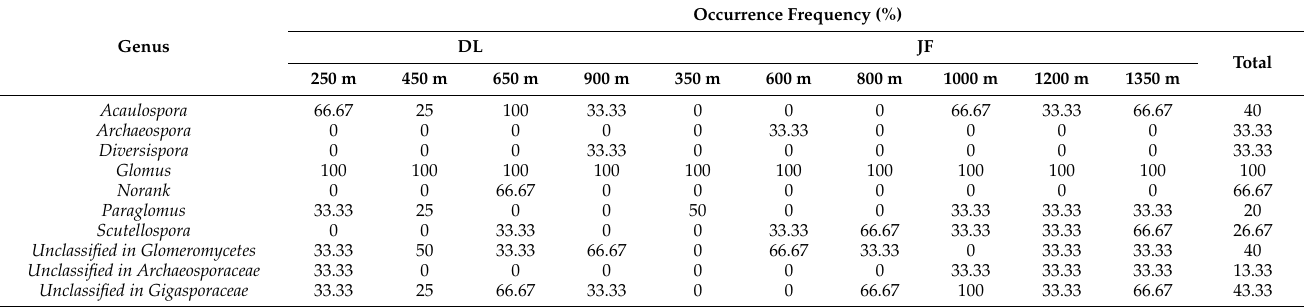
Table 1. AMF genus occurrence frequencies at different elevations in tropical forests of